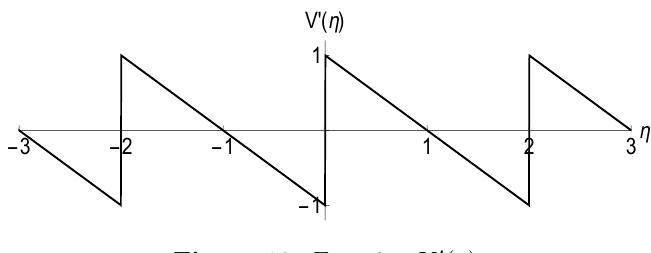
Figure 12. Function V 0 ( (cid:17)